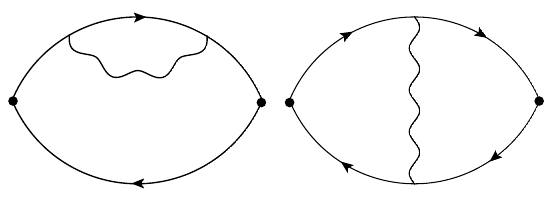
Figure 9 . Leading corrections to the boundary current two-point function for the Dirac